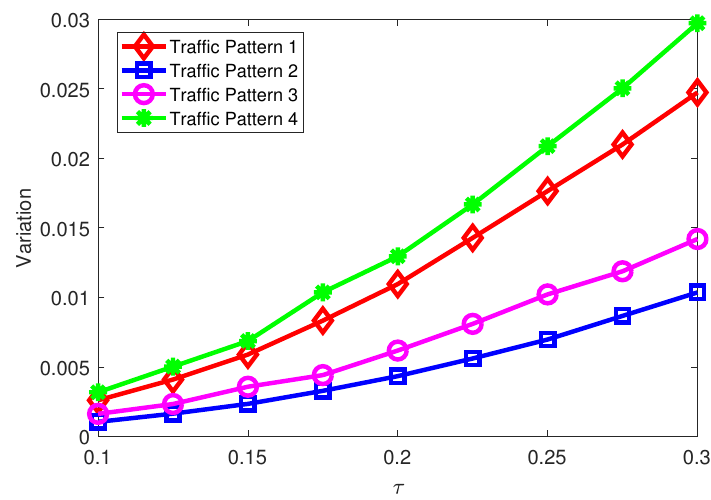
Figure 12. Impact of τ on sites’ variation in PARM.